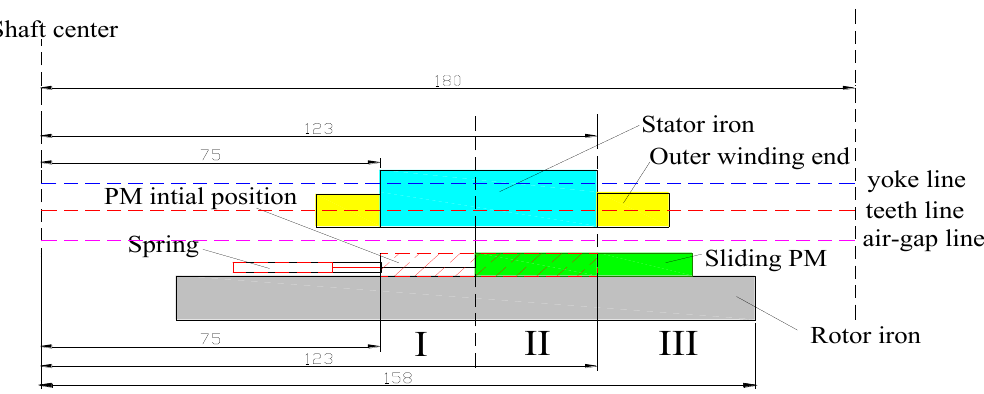
Figure 3. Half 3D finite-element-method (3D-FEM) model of the axial flux PM machine with PMs sliding outward.